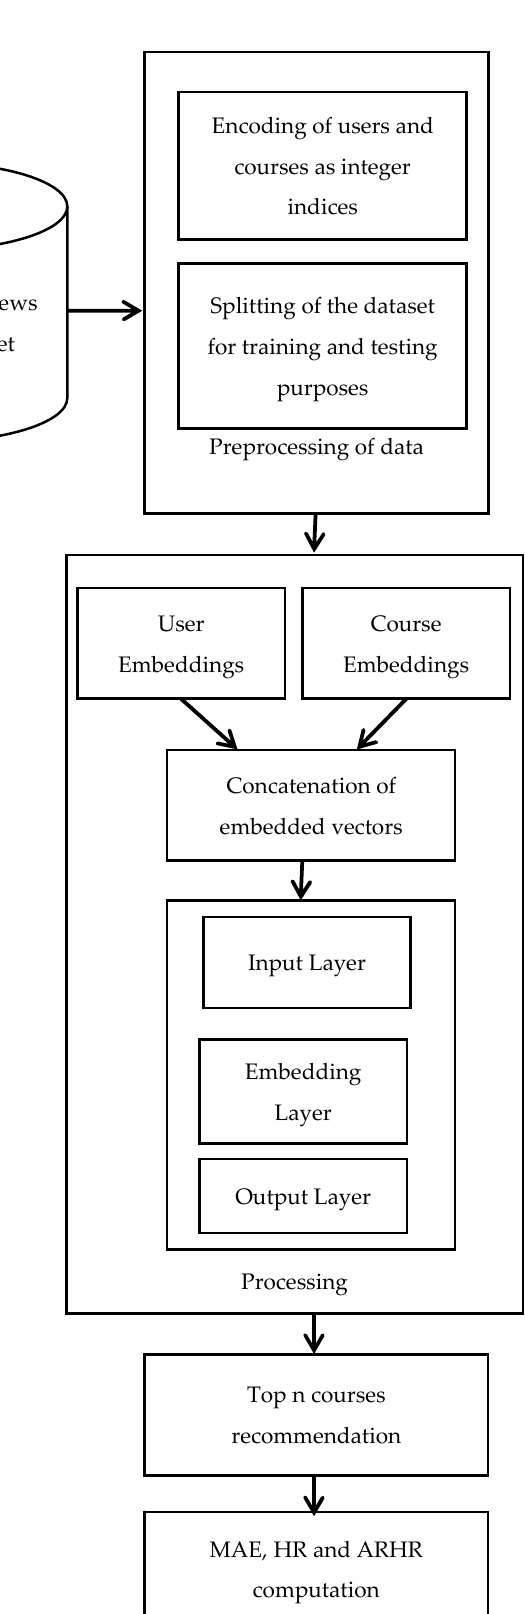
Figure 4. Workflow diagram of NCF.